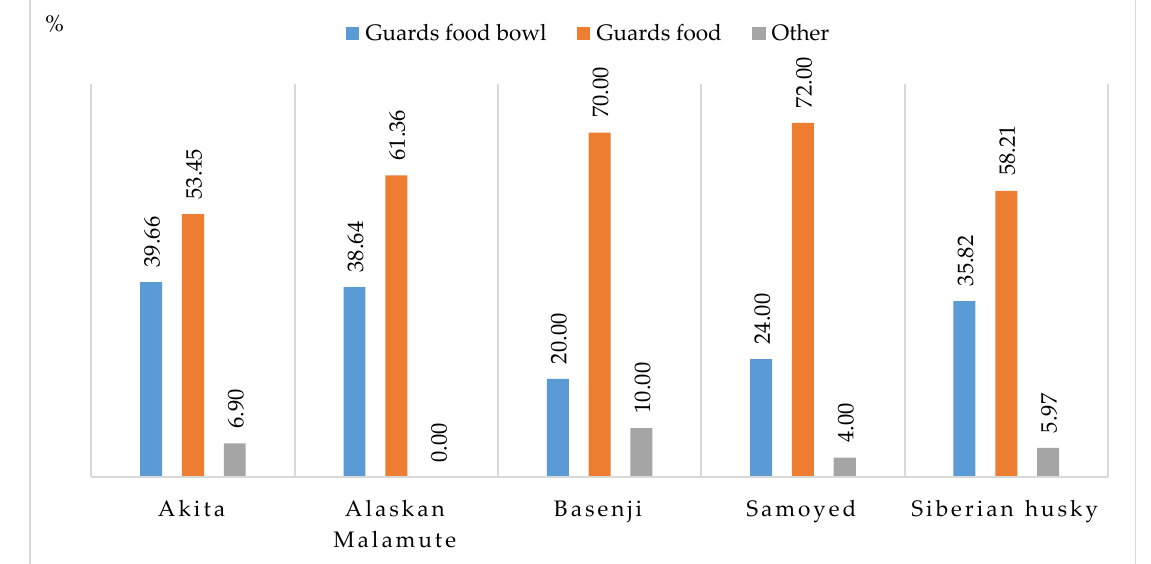
Figure 8. Aggression at meal time (%).